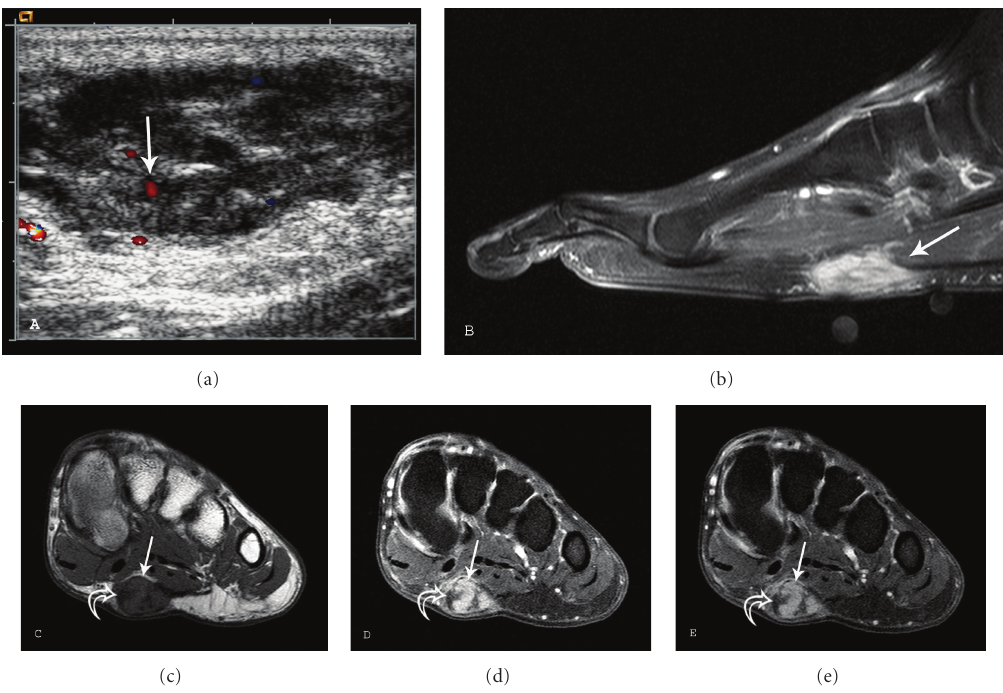
Figure 2: Plantar fibromatosis: a 54-year-old male who presents with left foot pain for one year. A longitudinal ultrasound color Doppler image (a) demonstrates a soft tissue mass with heterogeneous echotexture and internal color Doppler flow (arrow). (b) Sagittal T1-weighted (TR539.4/TE15) fat saturation postcontrast sequence demonstrates a fusiform, enhancing lesion with linear extension (fascial tail sign) along the plantar aponeurosis (arrow). Short axis MR images ((c)–(e)) demonstrate a well-defined mass (arrows) in the medial aspect of the plantar aponeurosis (c) Short axis T1-weighted (TR568/TE15) sequence reveals lesion signal intensity similar to skeletal muscle. There is heterogeneity with several foci of low signal (curved arrows) within the lesion. (d) Short axis T2-weighted (TR2693/TE60) with fat suppression reveals intermediate-to-high heterogeneous signal (arrow) and (e) T1-weighted (TR638.7/TE15) postcontrast fat saturation sequences demonstrate marked heterogeneous enhancement (arrow). Curved arrows indicate band-like areas of higher collagen content and low cellularity. Note the lower T1 and T2 signal intensity and lack of enhancement in these foci.